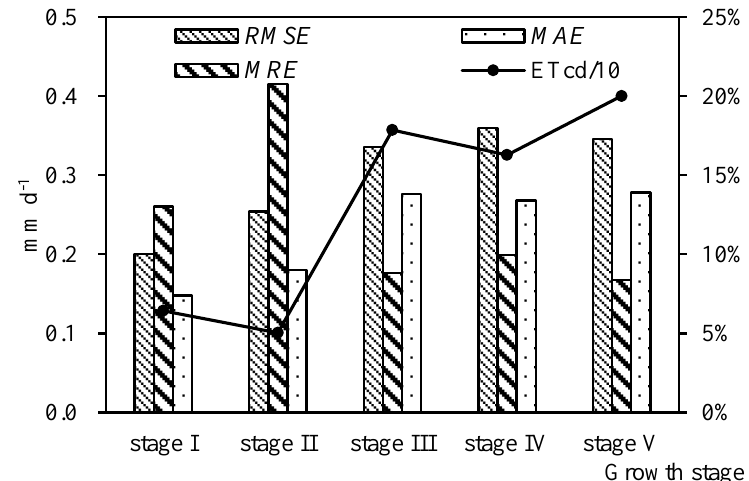
Figure 8. Average root mean square error ( RMSE ; mm d − 1 ), mean absolute error ( MAE ; mm d − 1 ), and mean relative error ( MRE ; %) of estimated winter wheat evapotranspiration using the crop coefficients optimized by the genetic algorithm, and observed mean daily evapotranspiration ( ET cd ) during each growth stage for five deficit irrigation treatments. Stage I: seedling stage; stage II: tillering stage; stage III: elongation stage; stage IV: heading stage; stage V: milk-ripe stage.